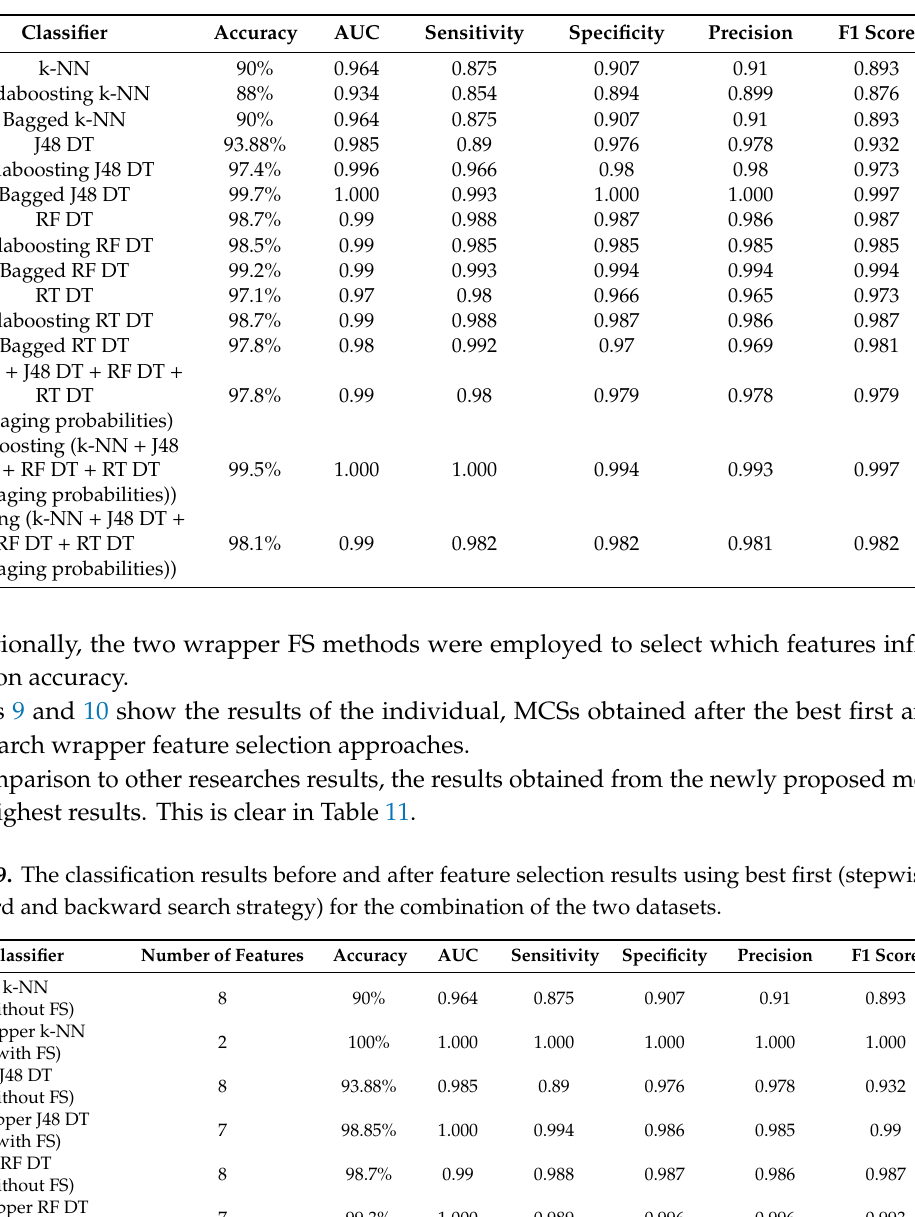
Table 8. The classification results of the four individual classifiers and the MCS constructed with all the four classifiers and their ensembles for the combination of the two datasets.